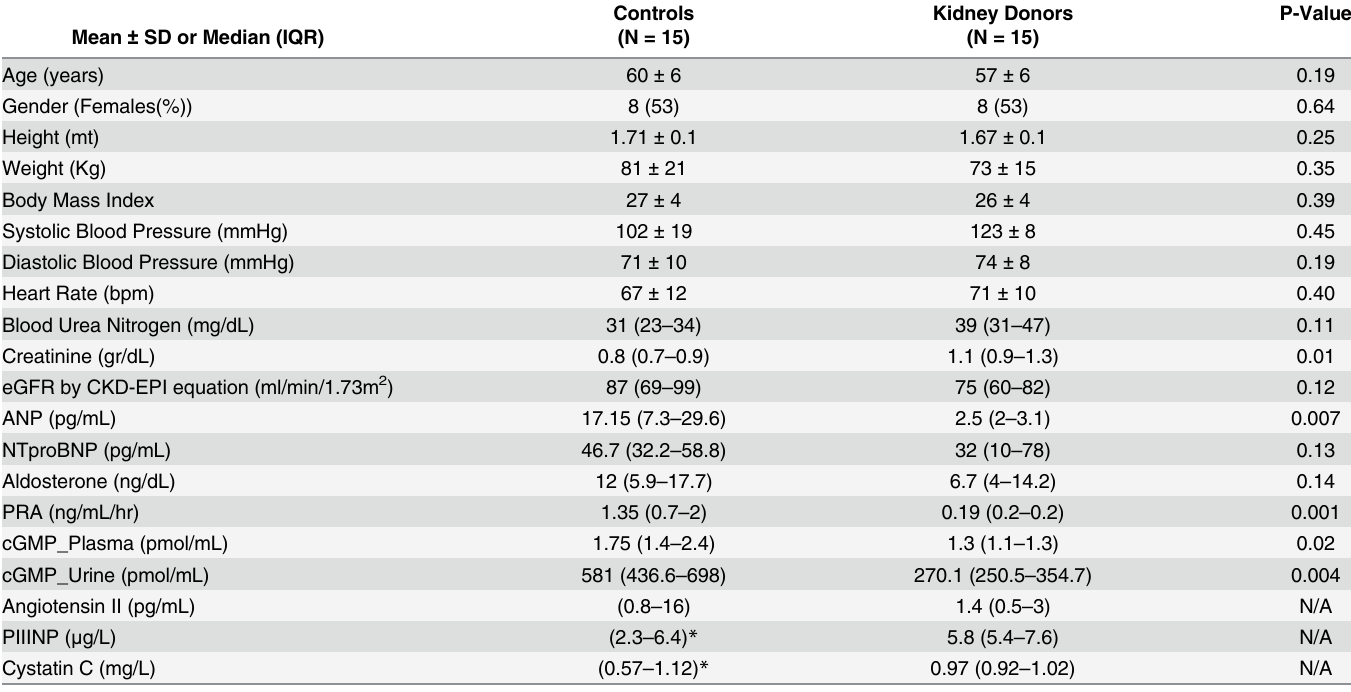
Table 1. (Definitive). Biometrics, Clinical characteristics and Biomarkers. Clinical variables, metabolic panel, liver function tests, and cardiovascular biomarkers in living kidney donors and controls. Descriptions are with mean ± standard deviation (SD), median (inter-quartile range) or count (percent).